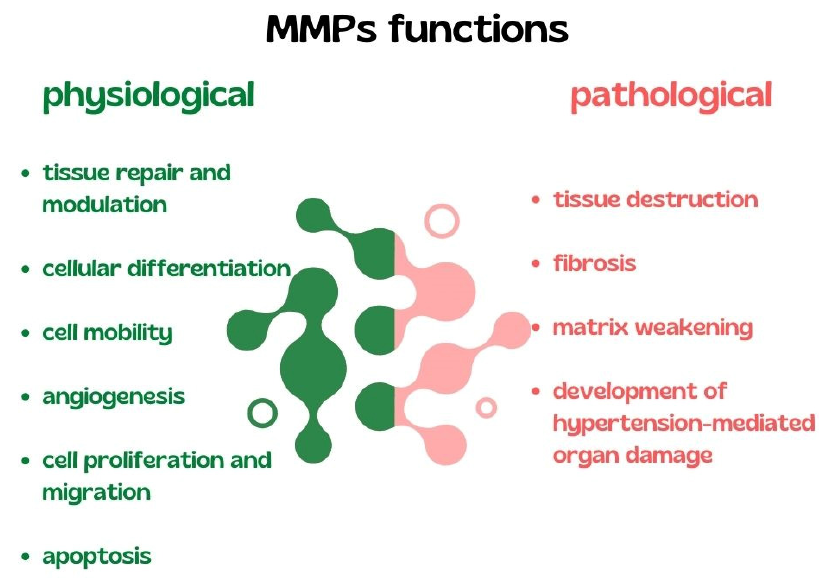
Figure 3. Summary of physiological and pathological functions of MMPs. MMPs, matrix metalloproteinases.